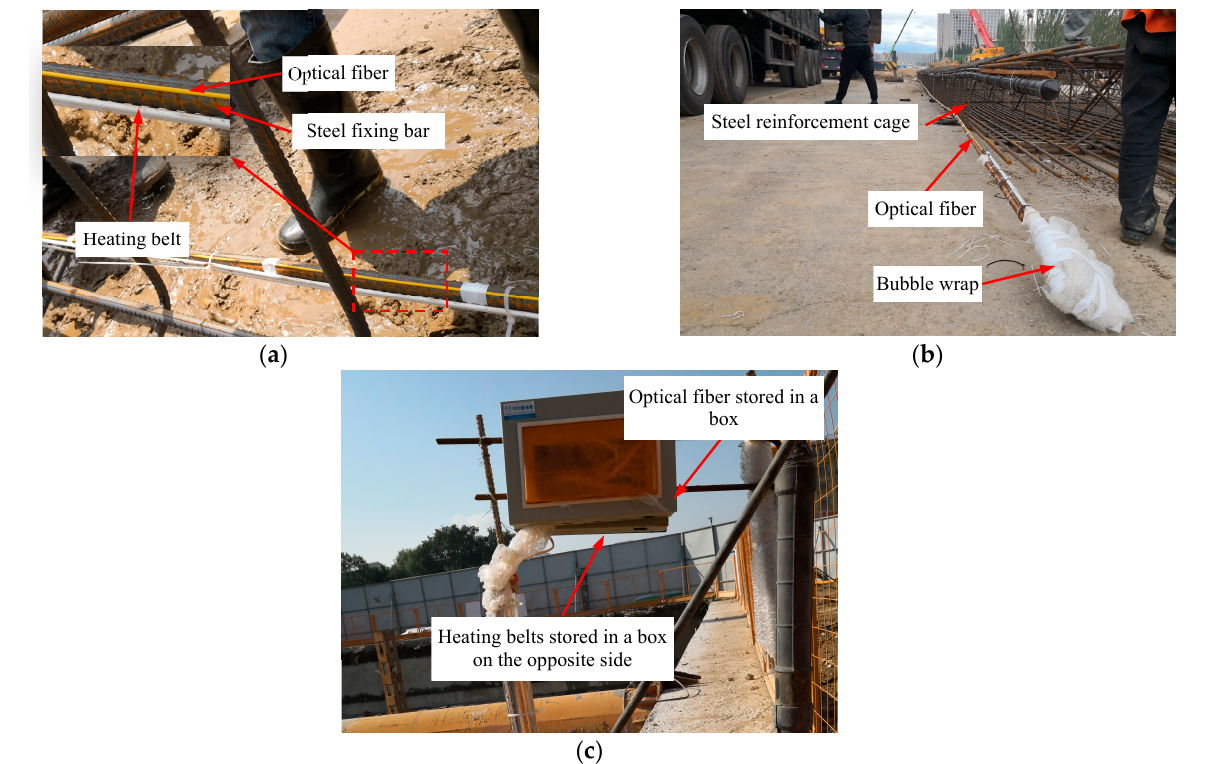
Figure 11. Installation of facilities at L2: ( a ) optical fibers and heating belts fixed onto the reinforcement cage; ( b ) cables outside the detection tube wrapped to protect them; ( c ) detection point L2 after finishing the installation of facilities.